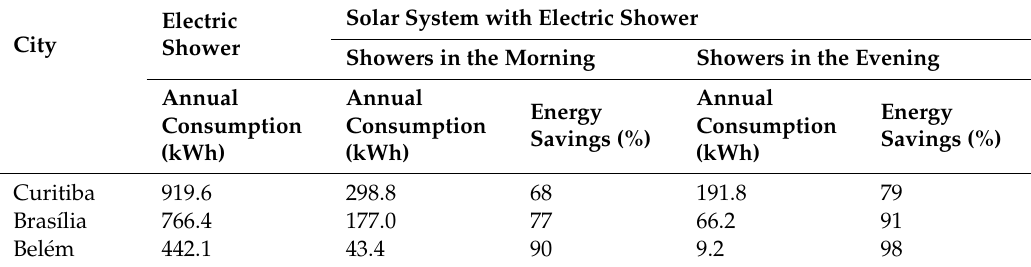
Table 6. Comparison of electricity consumption to heat water using either electric shower or solar water heating system with an electric shower. Solar System with Electric Shower Electric City Shower Showers in the Morning Showers in the